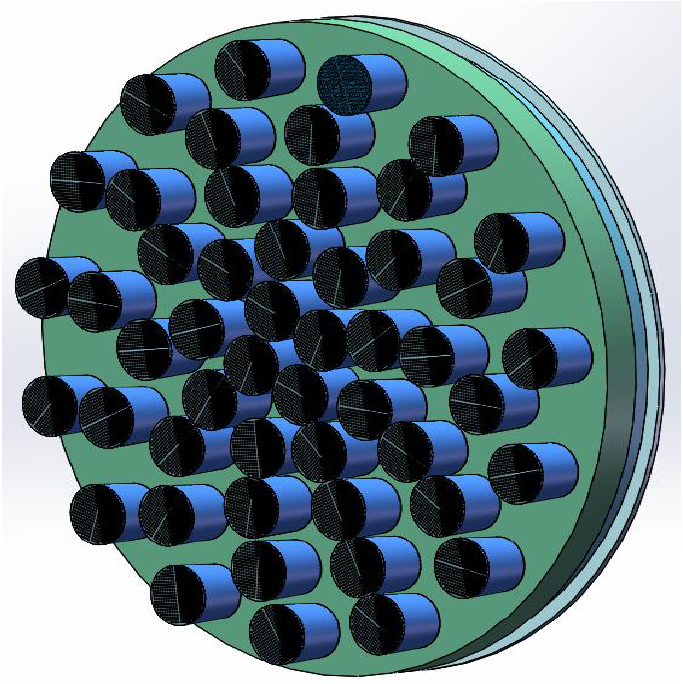
Figure 8. Assembly diagram of the secondary gas distribution device.